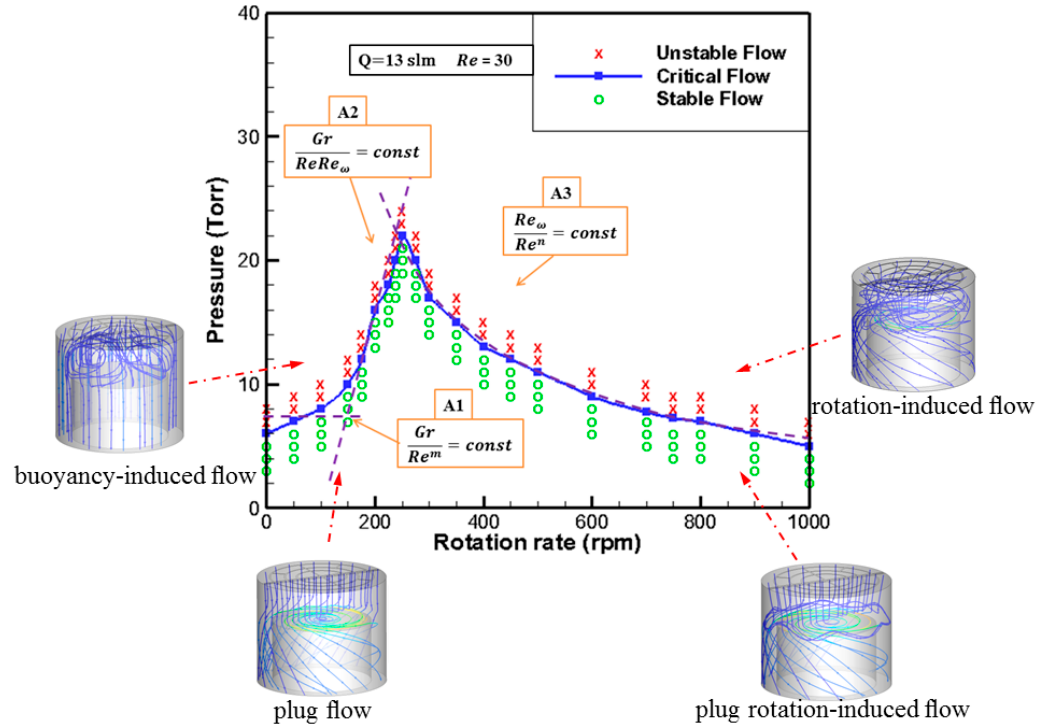
Figure 2. P- ω diagram for ZnO-MOCVD reaction chamber stability.